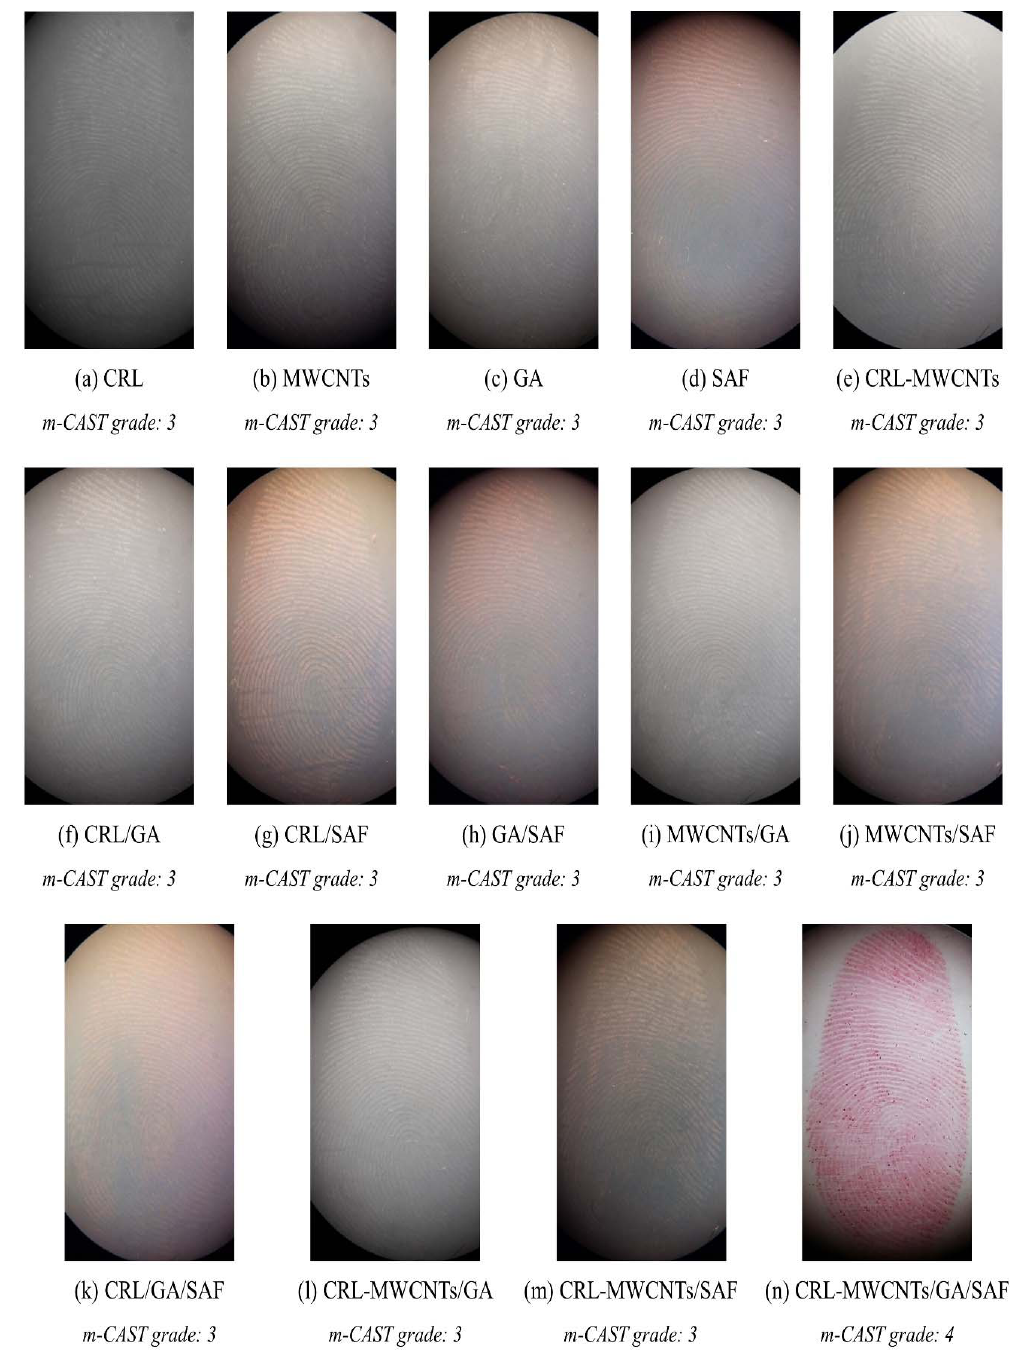
Figure 1. Visualization of latent fingerprints using various combinations of CRL, MWCNTs, GA and SAF observed at 7.5× magnification ( a – n ).